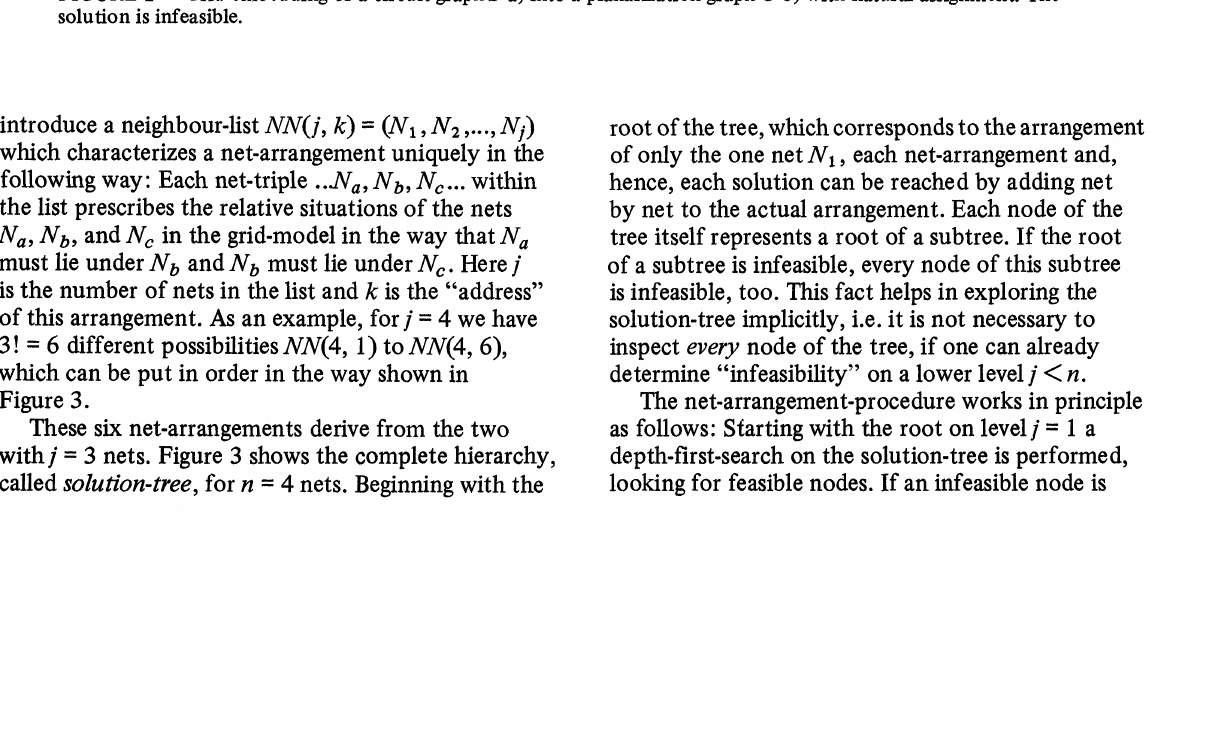
Grid-embedding of a circuit aph S a) into a planaration graph G b) with naturfl assignment. The solution is